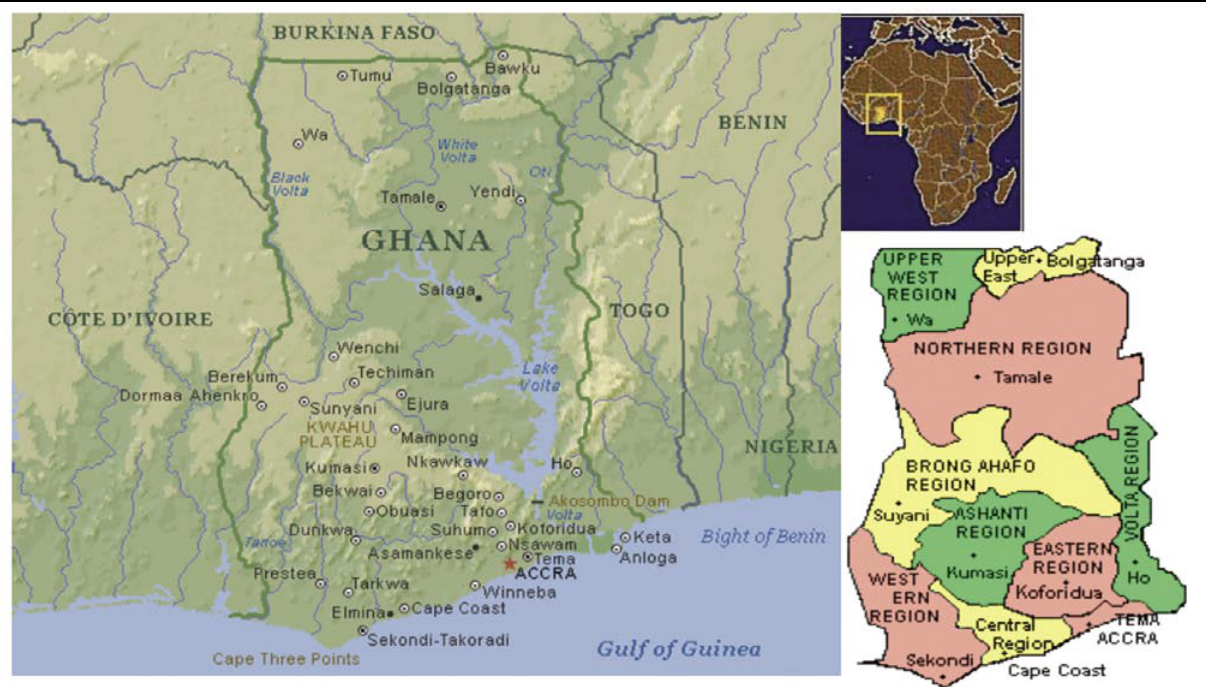
Figure 1. A geographical map of Ghana showing its location in Africa and its